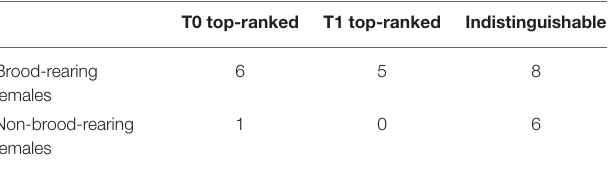
TABLE 1 | Summary of model ranking based on AIC c for translocated female sage-grouse in North Dakota in 2018–2020. T0 top-ranked T1 top-ranked Indistinguishable Brood-rearing 6 5 8 females Non-brood-rearing 1 0 6 females Model T0 is a null model including sagebrush cover, herbaceous cover, slope, and distance to roads as predictors and no time-dependence terms. Model T1 includes the four predictor and also a time-dependent term for selection for herbaceous cover. Both models were fit to a set of 26 translocated sage-grouse, of which 19 were brood- rearing females and seven were non-brood-rearing females. A model was considered top-ranked when 1 AIC c > 2 for the second-ranked model. If 1 AIC c ≤ 2, the models were